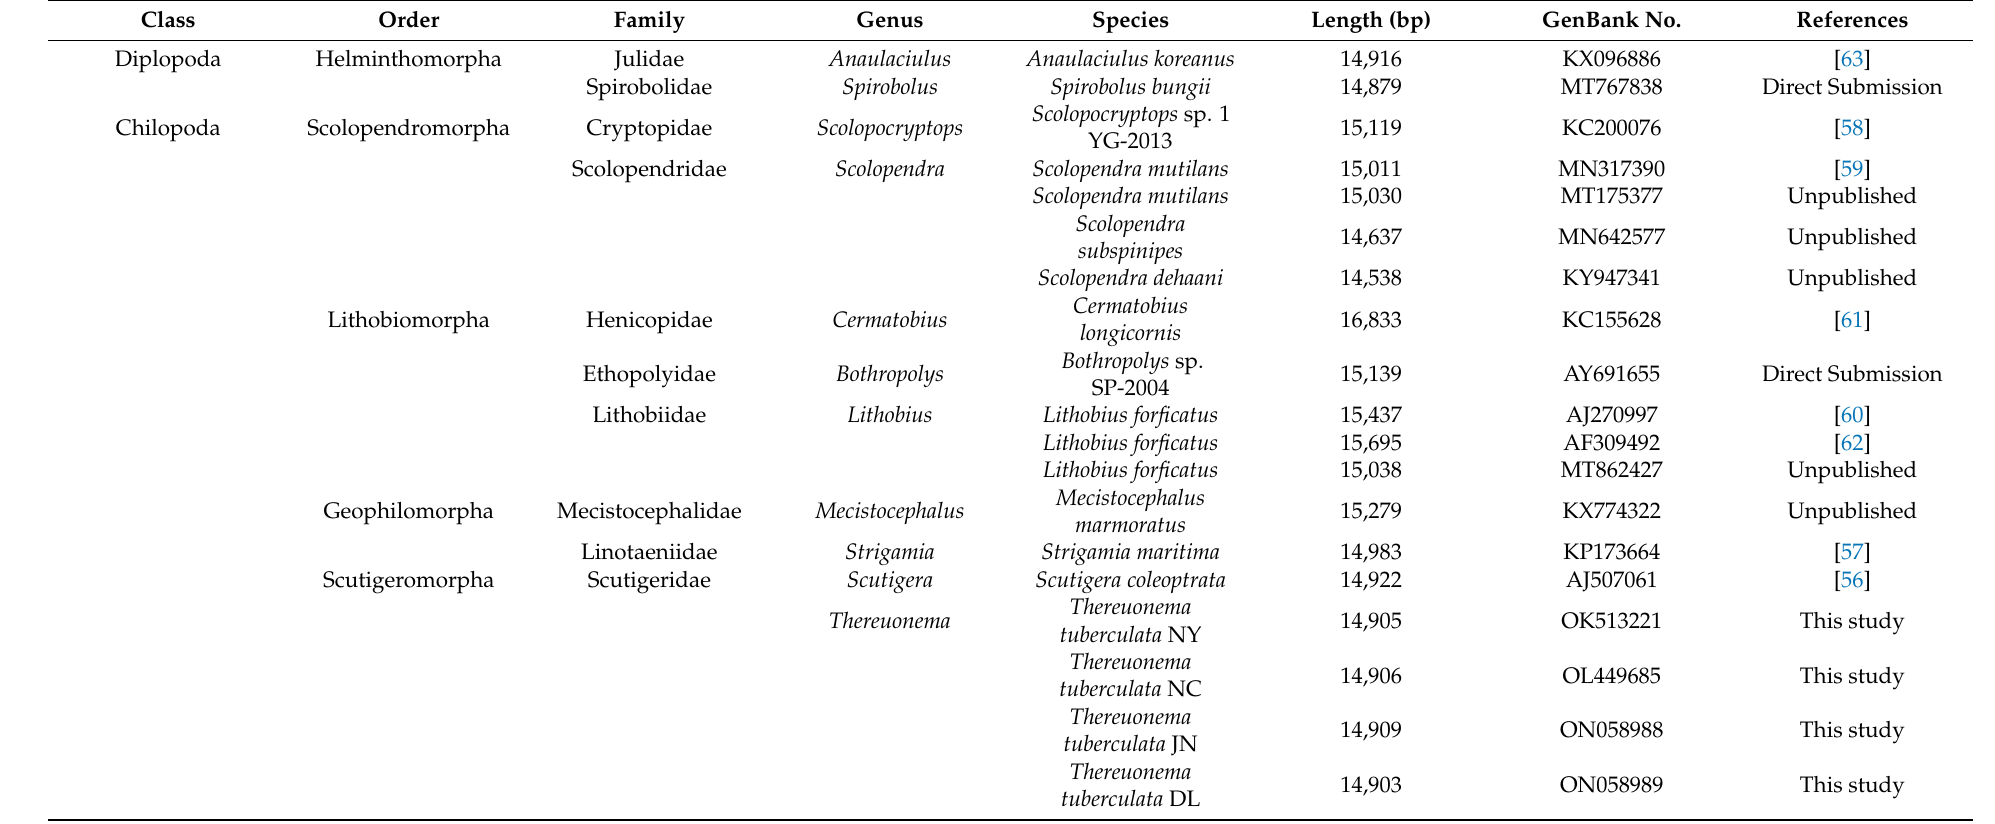
Table 2. Species used to construct the phylogenetic relationships along with GenBank accession